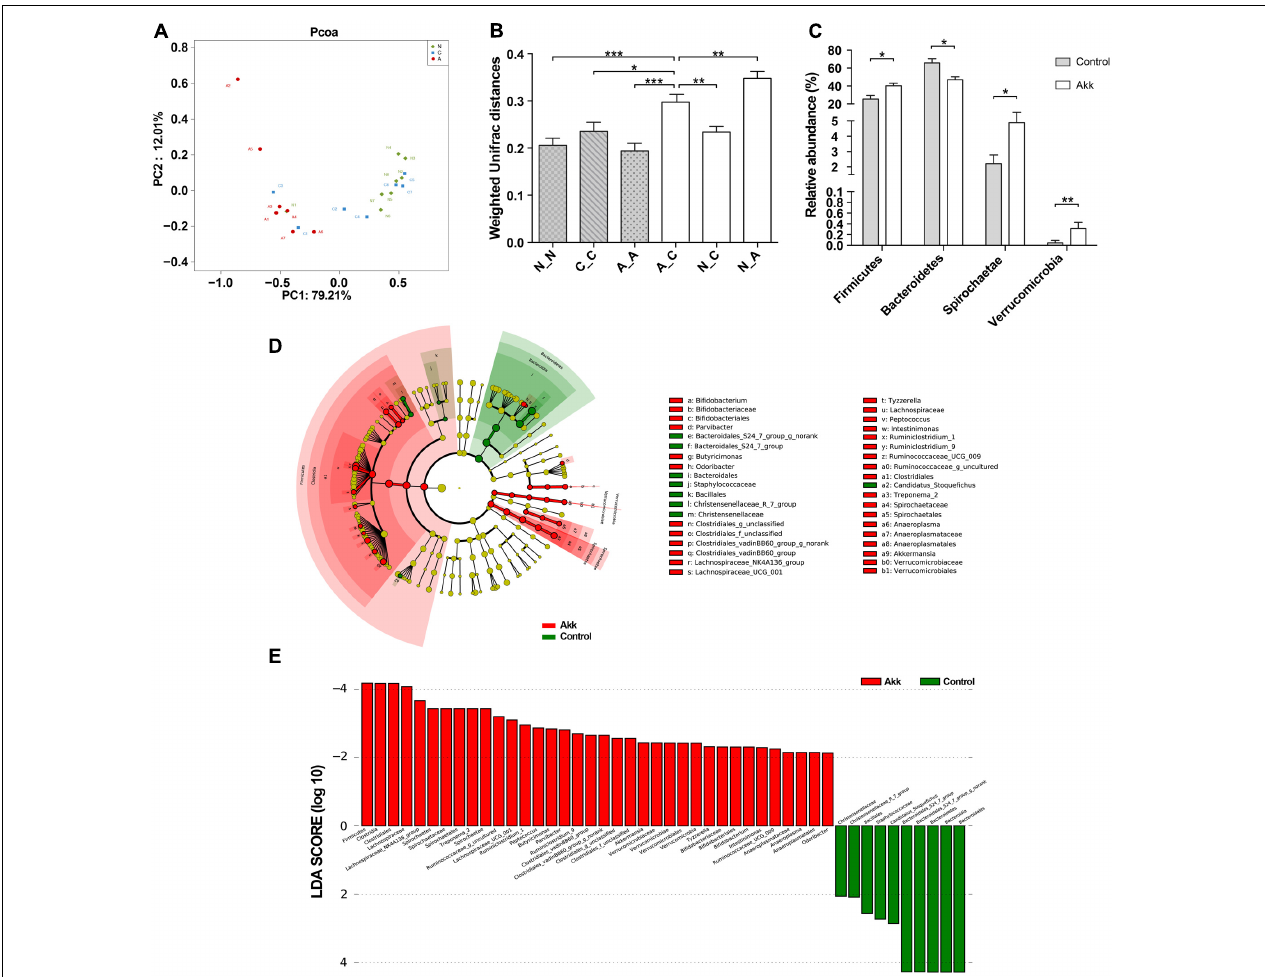
FIGURE 5 | Alteration of the microbial community. (A) PCoA among three groups based on Weighted UniFrac distances. Each point represented a sample. N, group Normal; C, group Control; A, group Akk. (B) Comparisons of pair-wised Weighted Unifrac distances. ANOVA was conducted for multiple comparisons with the LSD method for correction. N_N, C_C, and A_A, indicate intragroup distances; A_C, N_C, and N_A, indicate intergroup distances. (C) Relative abundance of taxa at the phylum level in group Control and Akk. Significance was determined by Wilcoxon rank sum tests. (D) LEfSe cladograms represented taxa enriched in group Control (green) and group Akk (red). Rings from the inside out represented taxonomic levels from phylum to genus. Sizes of circles indicate relative abundance of the taxon. (E) Discriminative biomarkers with twofold changes in LDA scores. Data are shown as the mean ± SEM. ∗ P < 0.05, ∗∗ P < 0.01, ∗∗∗ P <